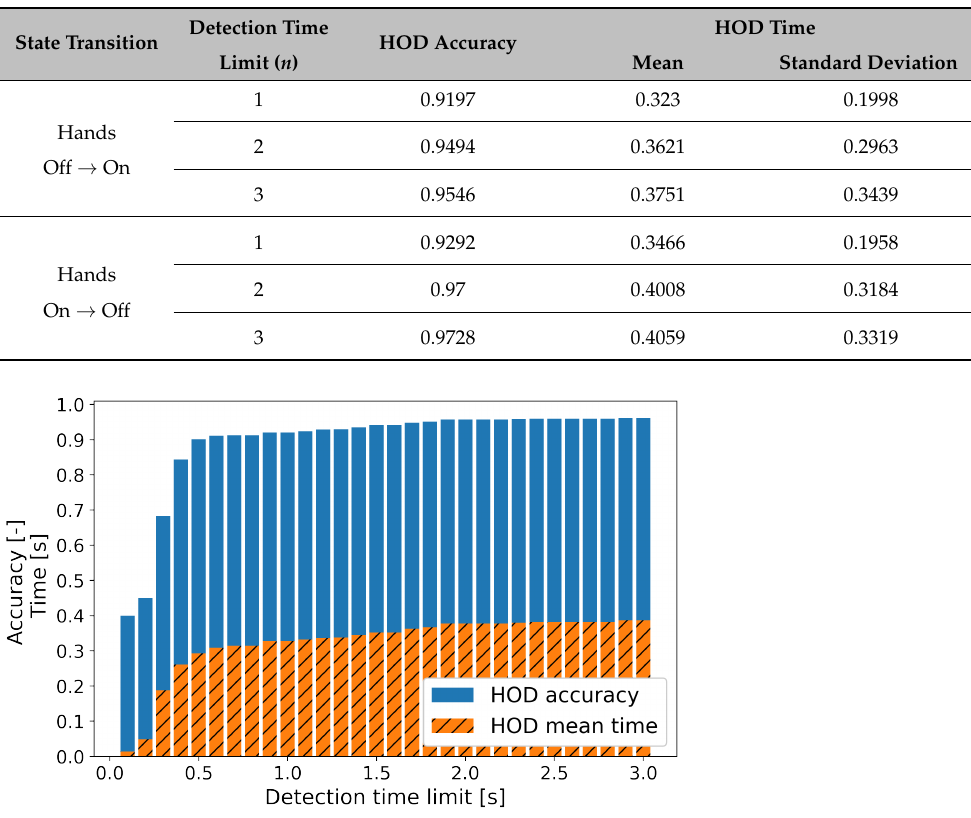
Table 7. HOD accuracy and time considering state transition on the test set (time window size = 10). The unit of detection time limit and HOD time is second.